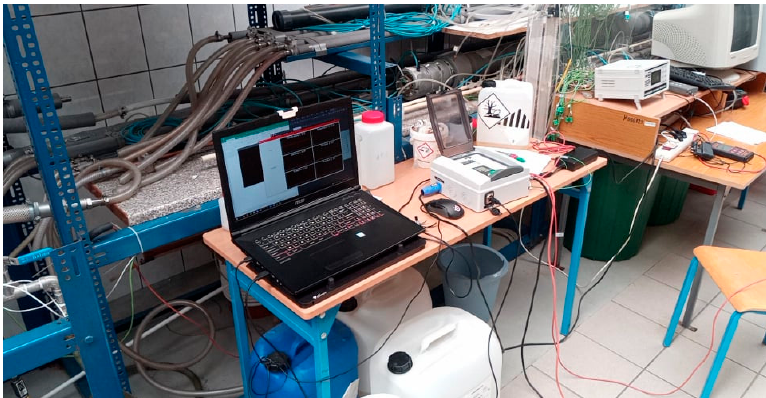
Figure 12. The PLC connected to the personal computer during the operation.